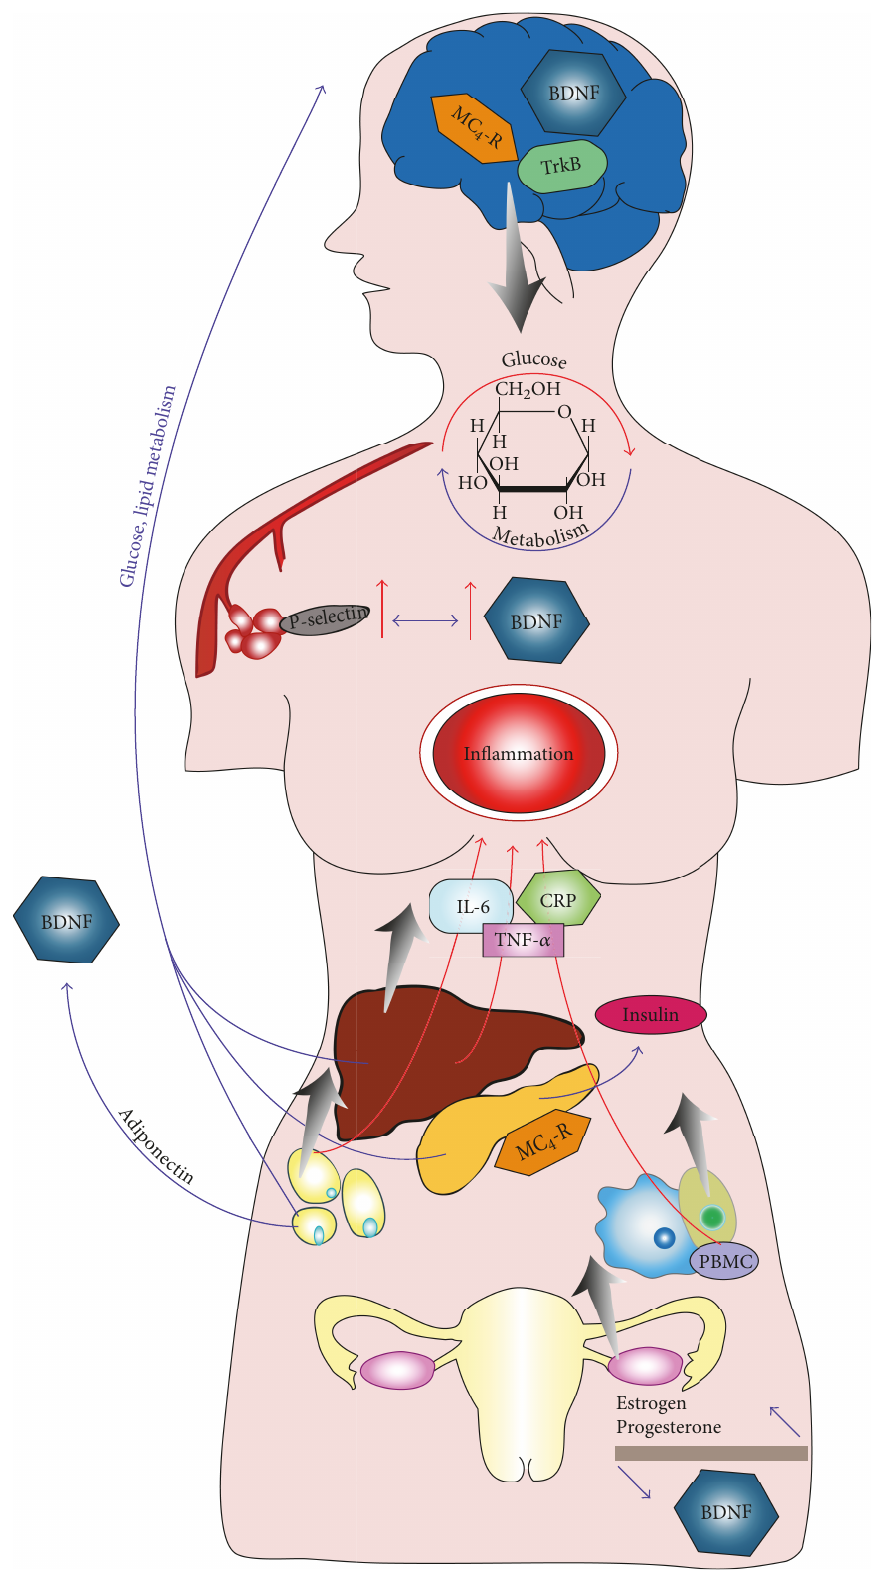
Figure 1: Brain-derived neurotrophic factor (BDNF) and its role on glucose haemostasis and potential relation with in fl ammation and type 2 diabetes mellitus (T2DM). MC -R: melanocortin 4 receptor; TrkB: tropomyosin receptor kinase B; IL-6: interleukin 6; TNF- α : tumor necrosis 4 factor alpha; CRP: c-reactive protein; PBMC: peripheral blood mononuclear